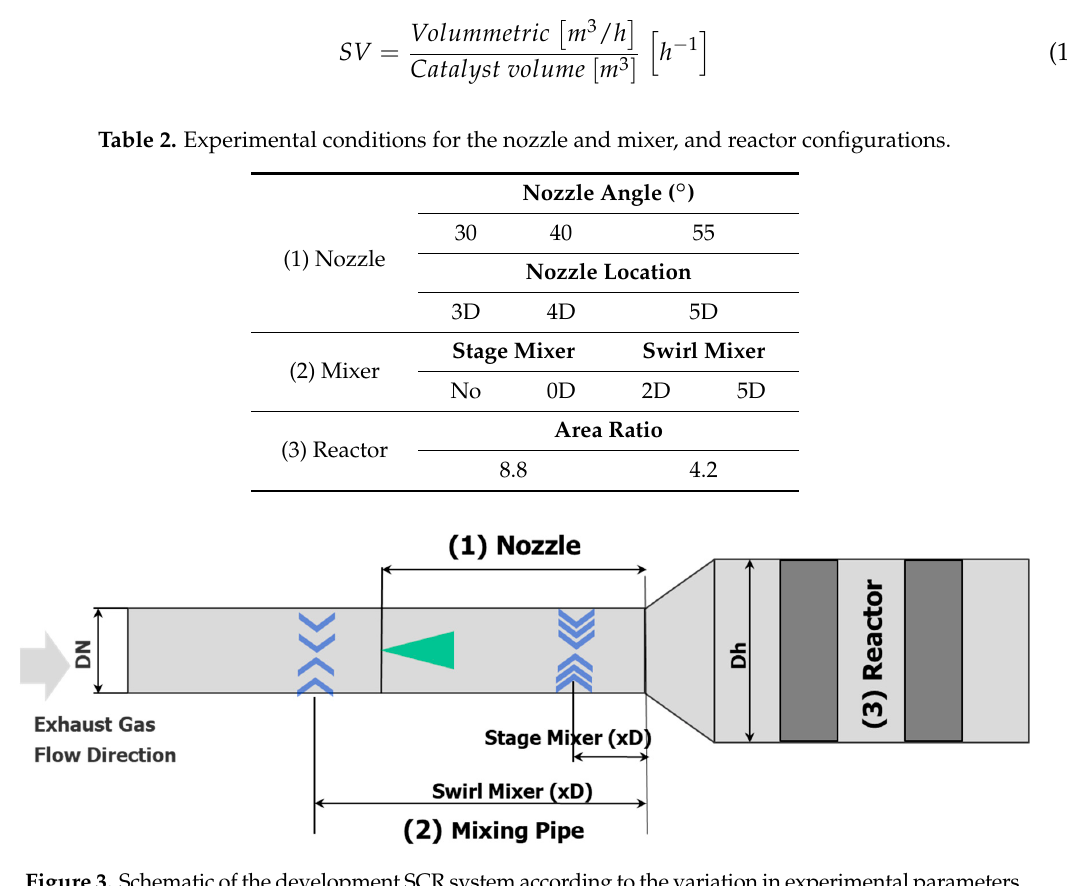
Figure 3. Schematic of the development SCR system according to the variation in experimental parameters.